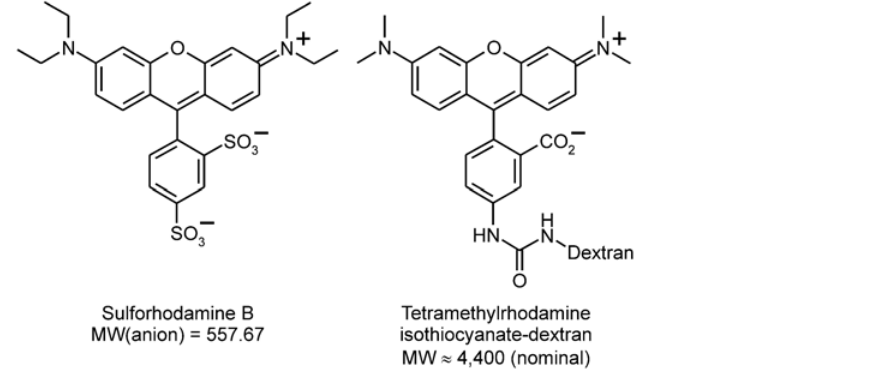
Fig 2. Fluid-phase fluorescent